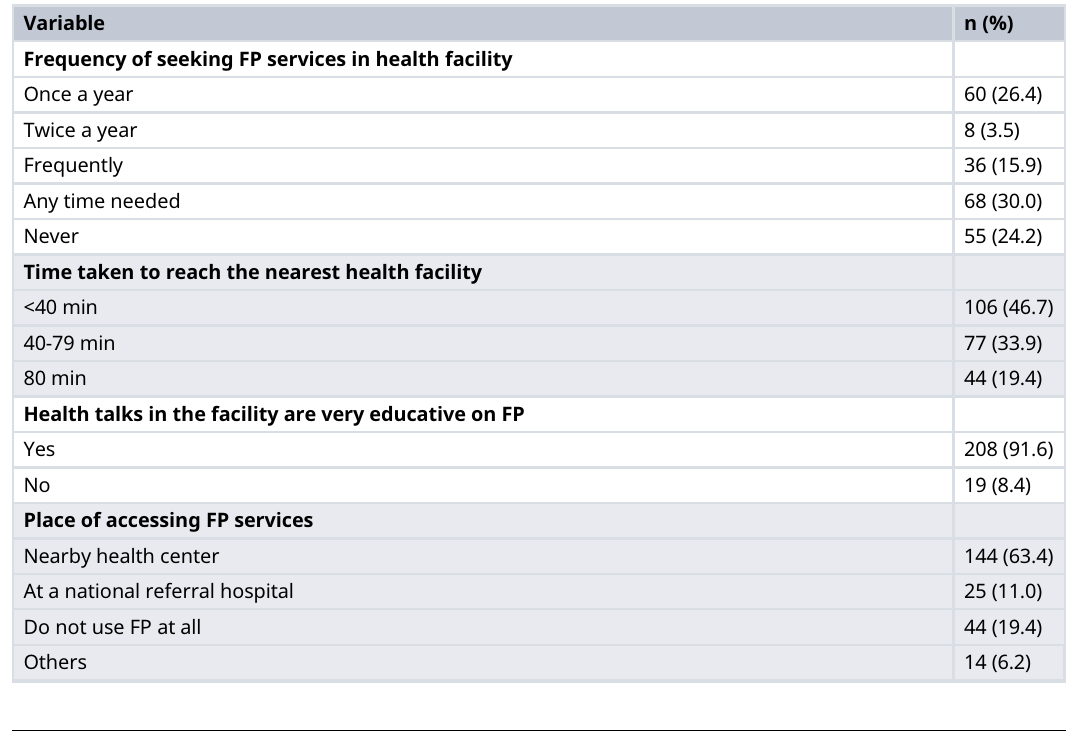
Table 4. Bivariate analysis: Association between pregnancy intention and the background characteristics among women attending antenatal clinic at KNH.